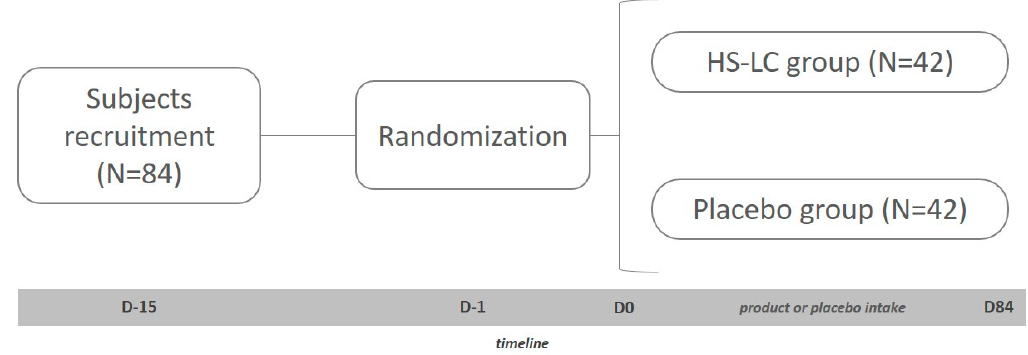
Figure 1. Graphic representation of the study. HS-LC, Hibiscus sabdariffa and Lippia